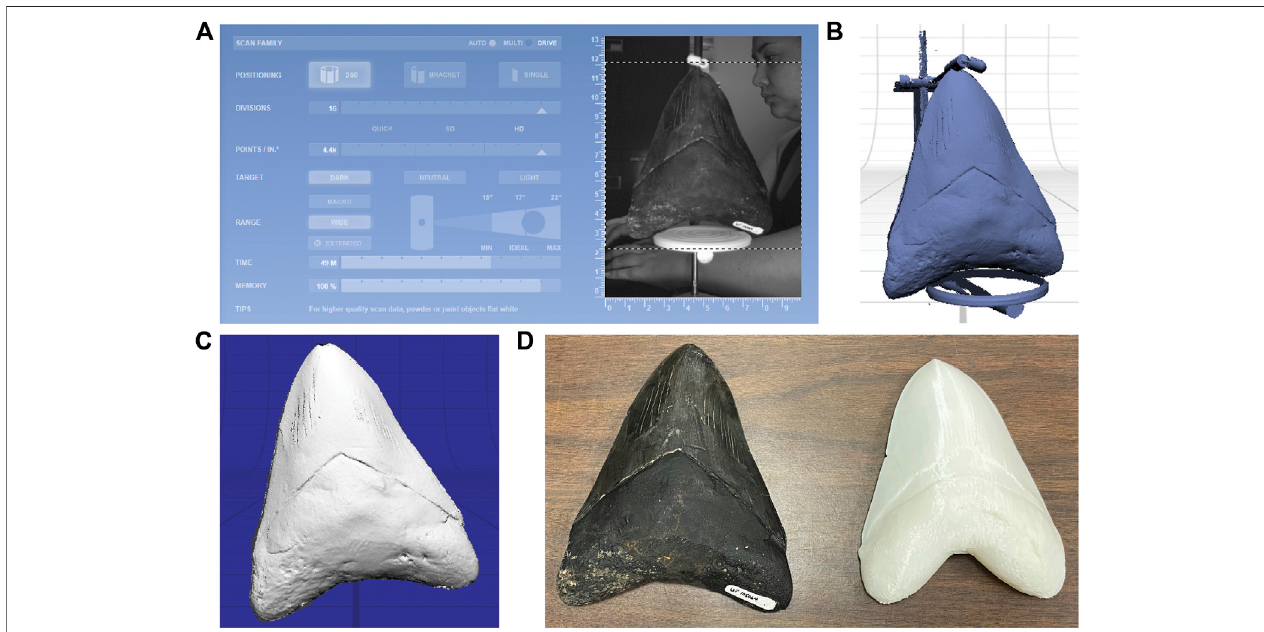
FIGURE 2 | Work fl ow for setting up, scanning and processing a fossil specimen using a NextEngine laser scanner (A) Scan settings to surface scan a tooth of C. megalodon (B) Surface scan of tooth prior to trimming (C) Surface scan of tooth after trimming, preparing for export of surface fi le (D) Actual specimen (left) next to 3D print of surface scan (right) of C. megalodon